Question: What direction does the quantity move in — increasing or decreasing?
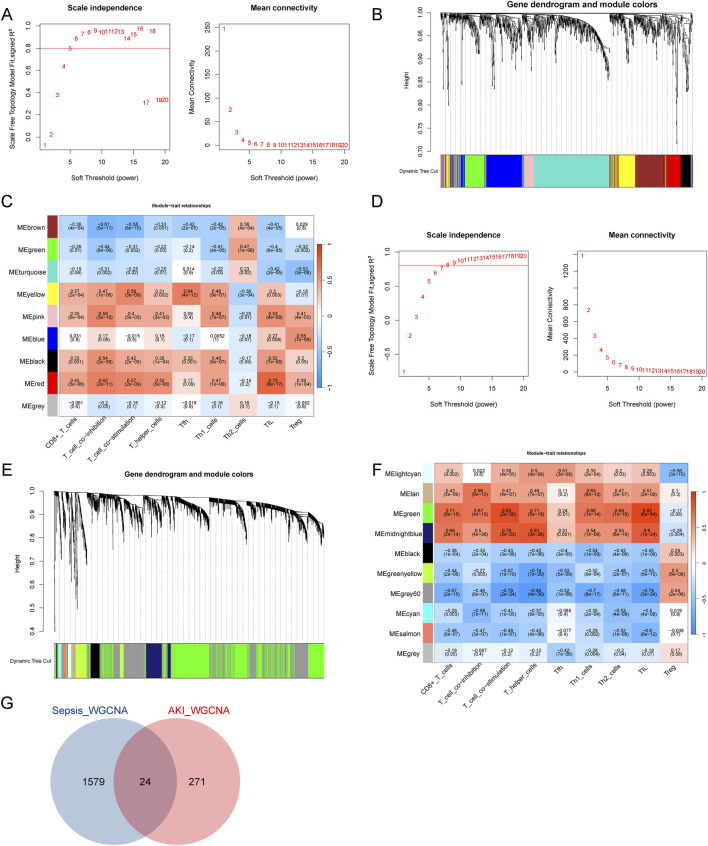
Answer: increasing